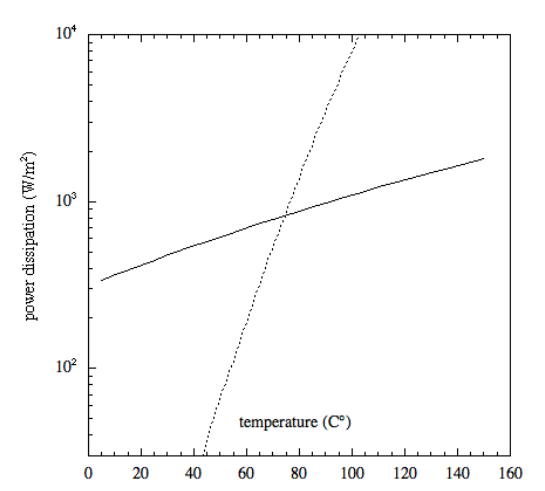
Figure 1. Energy loss contribution of magnesite MgCO 3 : the solid line represents the radiative loss, the dashed line stands for the evaporation